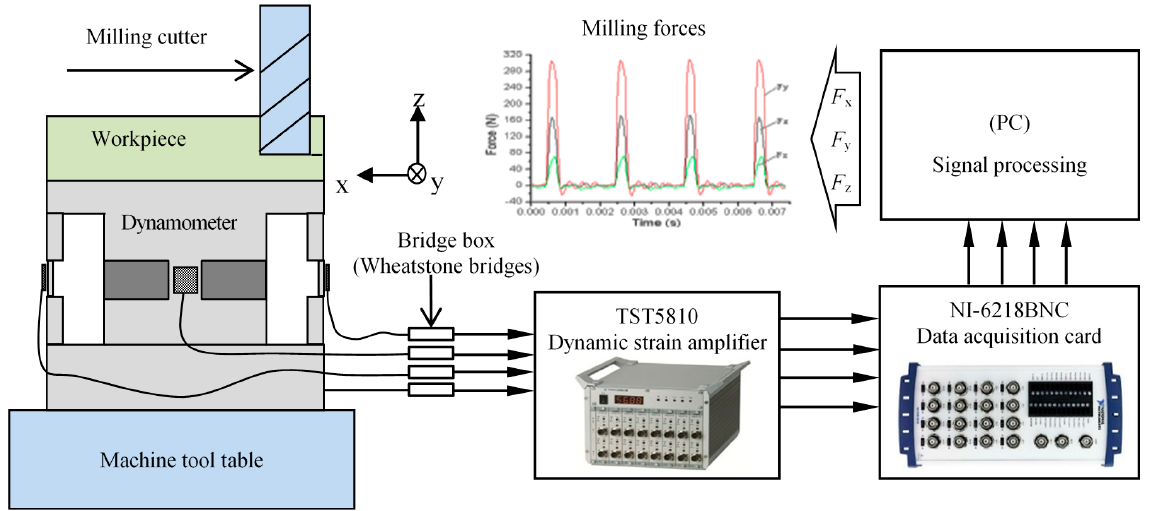
Figure 1. A schematic illustration of the milling force measurement systems.